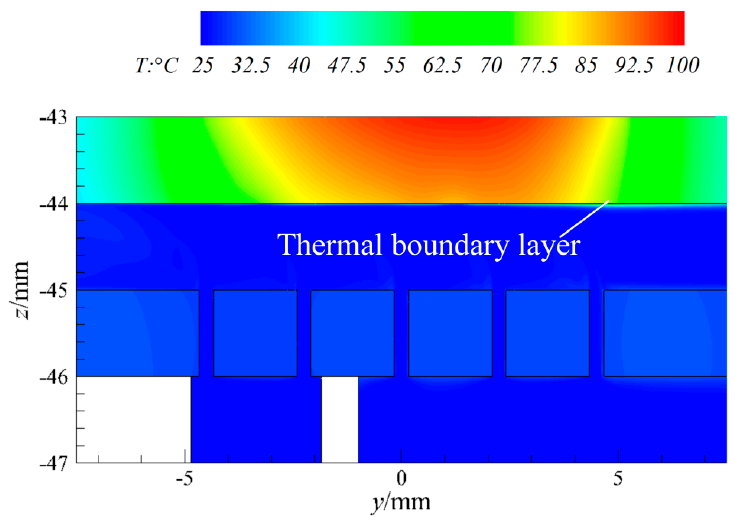
Figure 7. Temperature distribution (DSJ off) of channel’s center section ( x = 28.5 mm).